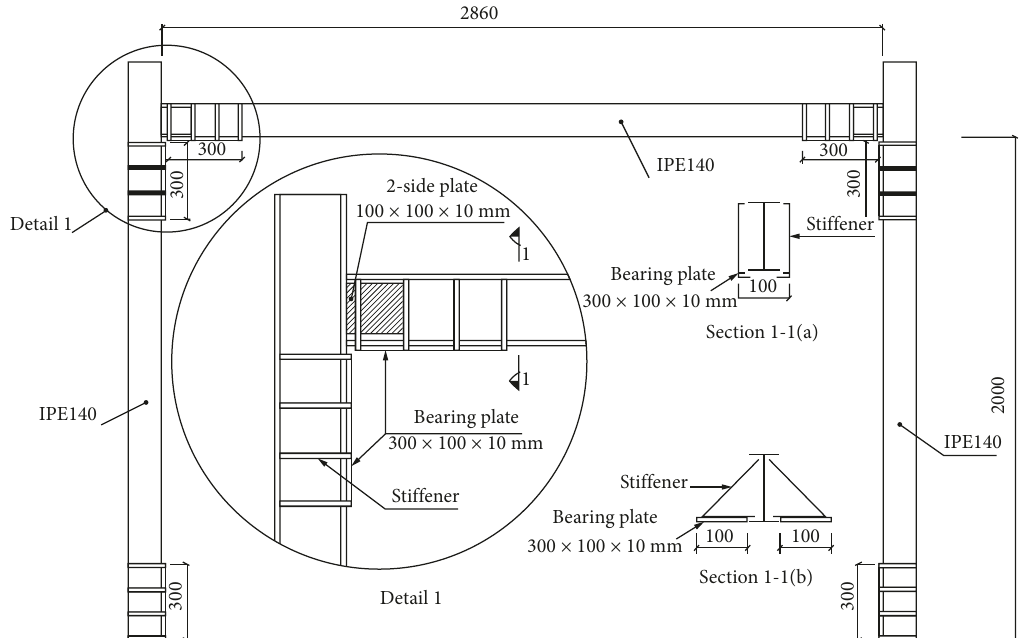
Figure 5: Geometrical characteristics of the benchmark model [24].